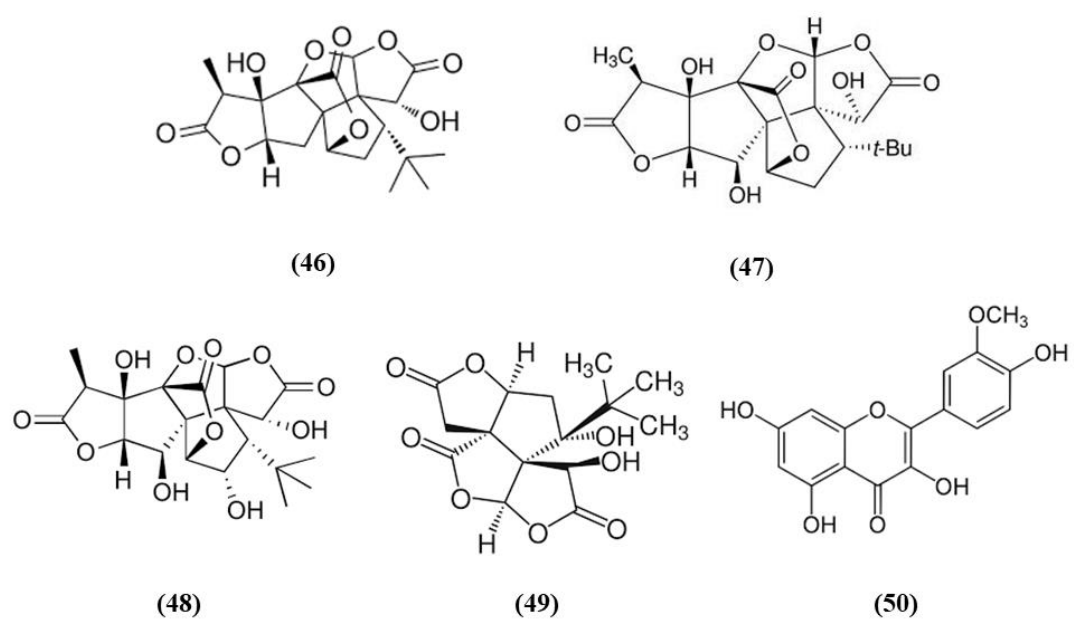
Figure 9. Chemical structure of ( 46 ) ginkgolides A, ( 47 ) ginkgolides B, ( 48 ) ginkgolides C, ( 49 ) bilobalide, and ( 50 ) isorhamnetin.